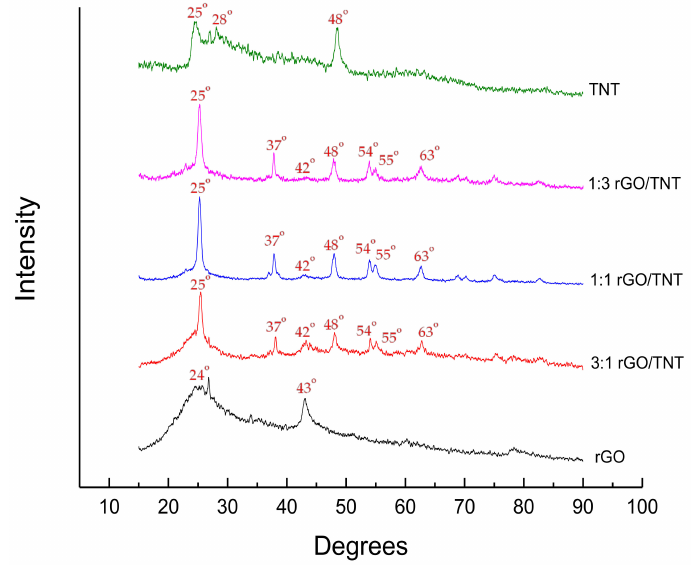
Figure 14. XRD of rGO/TNT composites and pure